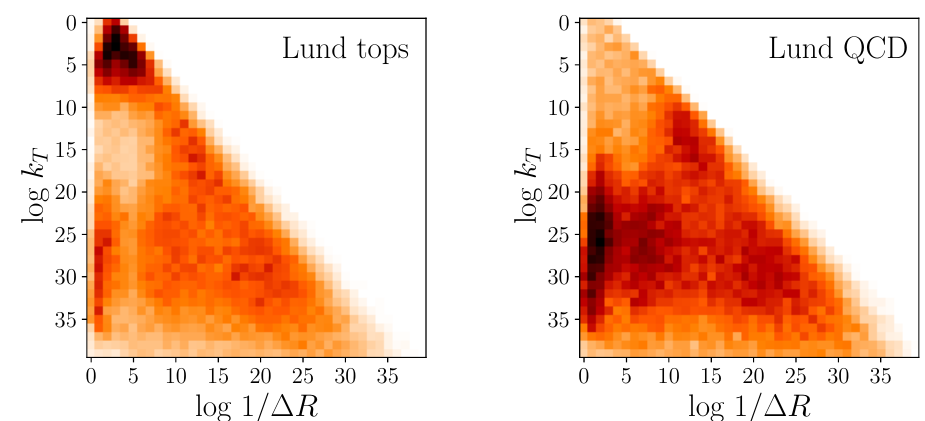
Figure 14: Average of 100k QCD and top jet images in the primary Lund plane rep- resentation. The x and y axis show the pixel numbers, but these axis go from 0 to 6 and − 2 to 5,